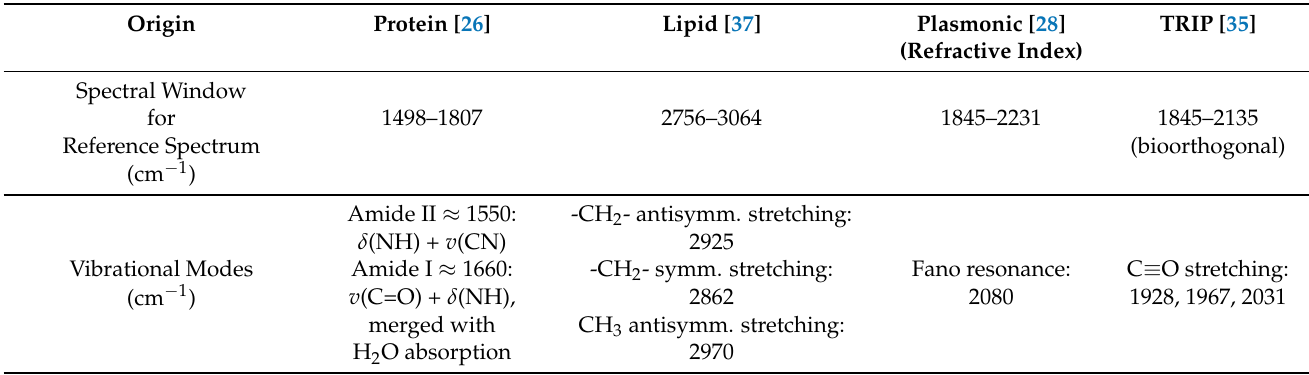
Table 1. The vibrational peak assignments for each spectral windows. δ : bending; v :